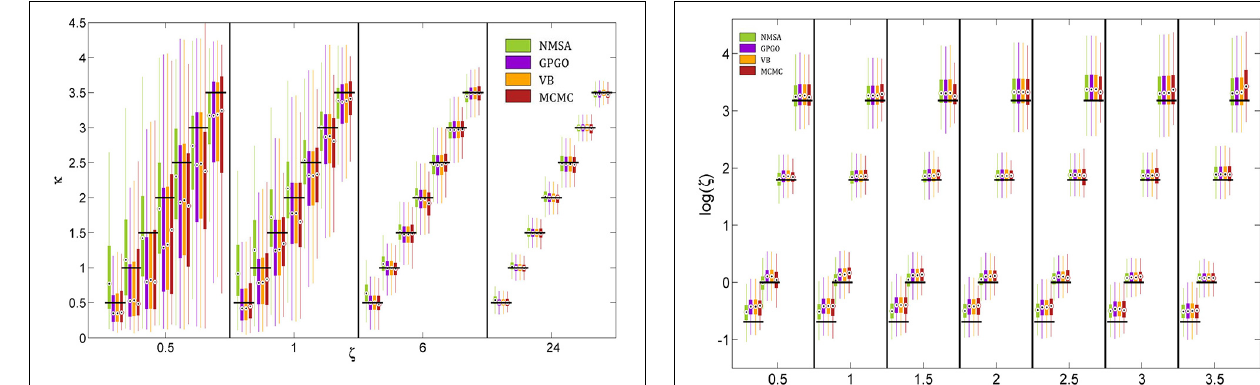
FIGURE 7 | Estimation of coupling κ by four methods at different noise levels ζ . A range of κ from 0.5 to 3.5 was chosen based on the range of estimates observed in the analysis of experimental data. Decision noise levels were chosen in a range from very high (0.5) to very low (24). The remaining model parameters were held constant ( ω = − 4, ϑ = 0 . 0025). For each point of the resulting two-dimensional grid, 1000 task runs with 320 decisions each were simulated. Given the fixed sequence of inputs and simulated sequence of decisions, we then attempted to recover the model parameters, including κ and ζ , by four estimation methods: (1) the function Nelder-Mead simplex algorithm (NMSA), (2) Bayesian global optimization based on Gaussian processes (GPGO), (4) variational Bayes (VB), and Markov chain Monte Carlo sampling (MCMC). The figure shows boxplots of the distributions of the maximum-a-posteriori (MAP) point estimates for the four methods at each grid point. Boxplots consist of boxes spanning the range from the 25th to the 75th percentile, circles at the median, and whiskers spanning the rest of the estimate range. Horizontal shifts within ζ levels are for readability. Black bars indicate ground truth.